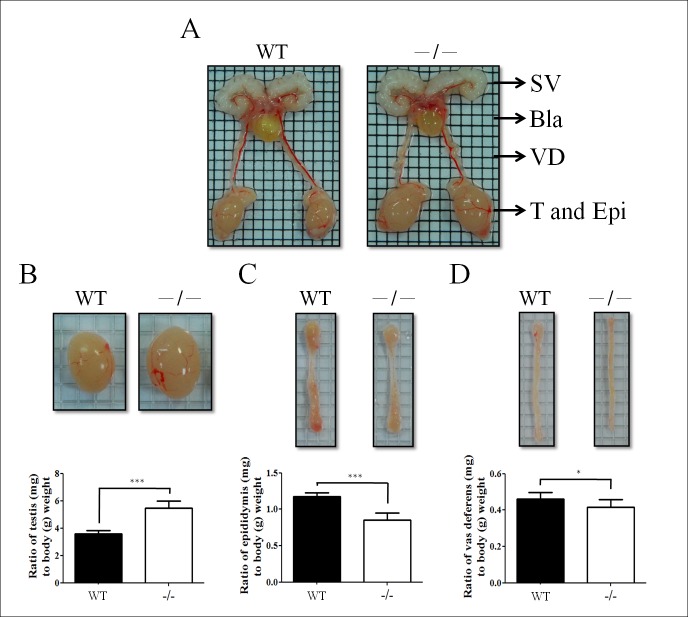
Gross morphology of the reproductive organs of infertile Slc9a3-/- male mice.(A) Intact appearance of overall reproductive organs, including the seminal vesicle (SV), bladder (Bla), vas deferens (VD), testis (T), and epididymis (Epi), of 2-month-old WT and Slc9a3 deficiency mice. (B, C, and D) Enlarged images of the testis (B), epididymis (C), and vas deferens (D). Statistics show the ratio of the normalized organ weight (mg) to body weight (g). Each bar represents the mean ± SEM; n = 10 per genotype. *Significant difference compared with WT mice (*p < 0.05 and ***p < 0.0001, analyzed using the Student’s t test).